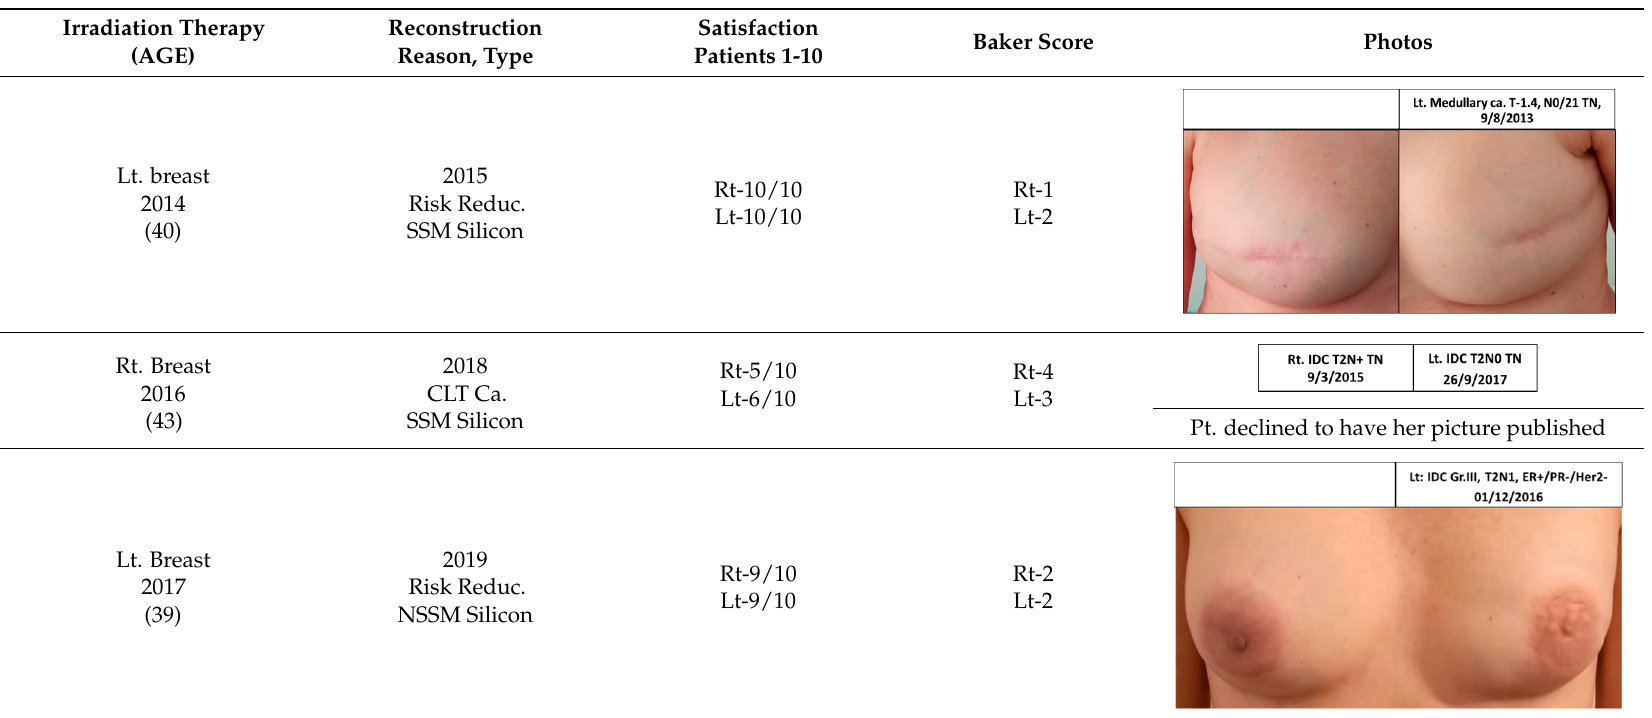
Risk Reduc.—risk reduction; CLT—contralateral; DCIS—ductal carcinoma in situ; Ca—cancer; Local Rec.—local recur- rence; SSM—skin-sparing mastectomy; NSSM—nipple- and skin-sparing mastectomy. Table 3. Patients’ satisfaction and Baker score for breast reconstruction after prior breast irradiation (left) versus not (right). Patient Time from Patient Reconstruction Baker Baker Reconstruction Breast Reconstruction Breast Satisf. Irradiation to Satisf. After Irradiation Score Score No Irradiation Cancer After Irradiation Cancer Reconstruction 1–10 Reconstruction 1–10